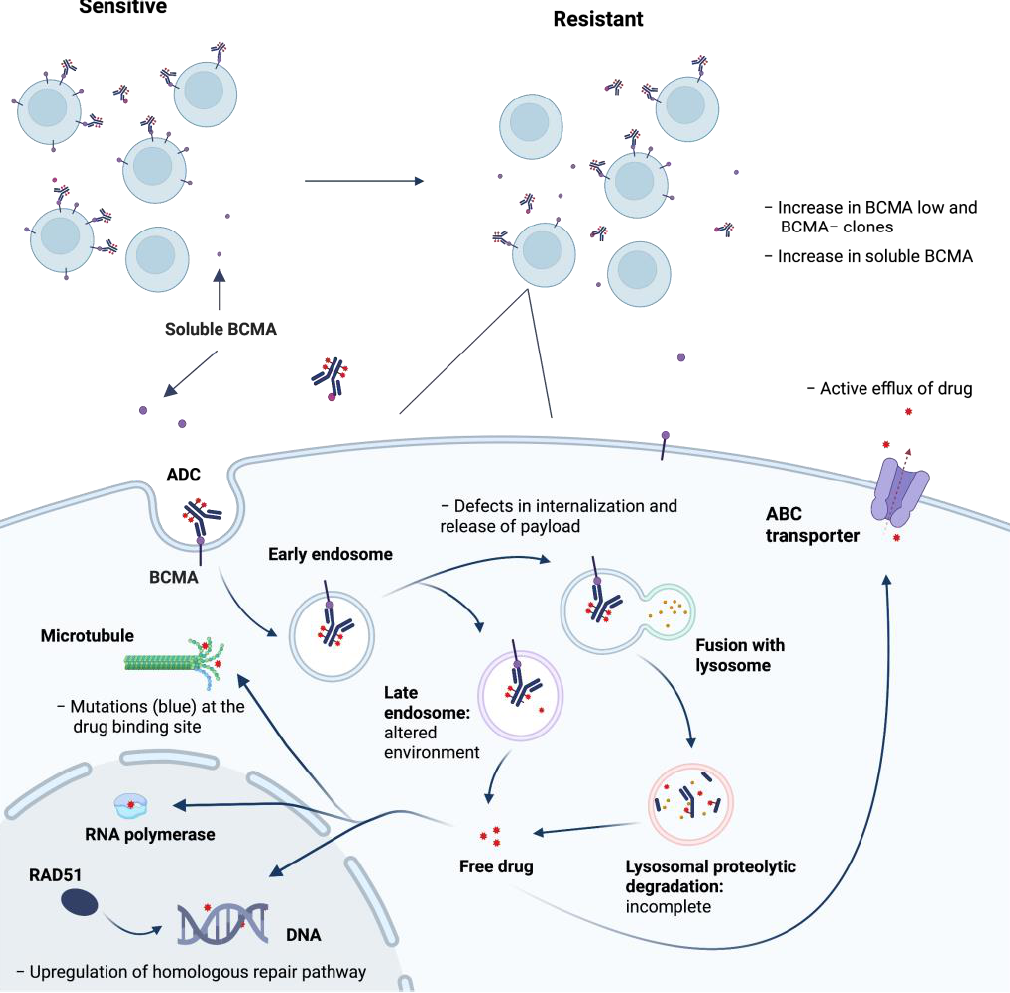
Figure 2. General resistance mechanism of anti-BCMA ADC in treating multiple myeloma. Created with BioRender.com.